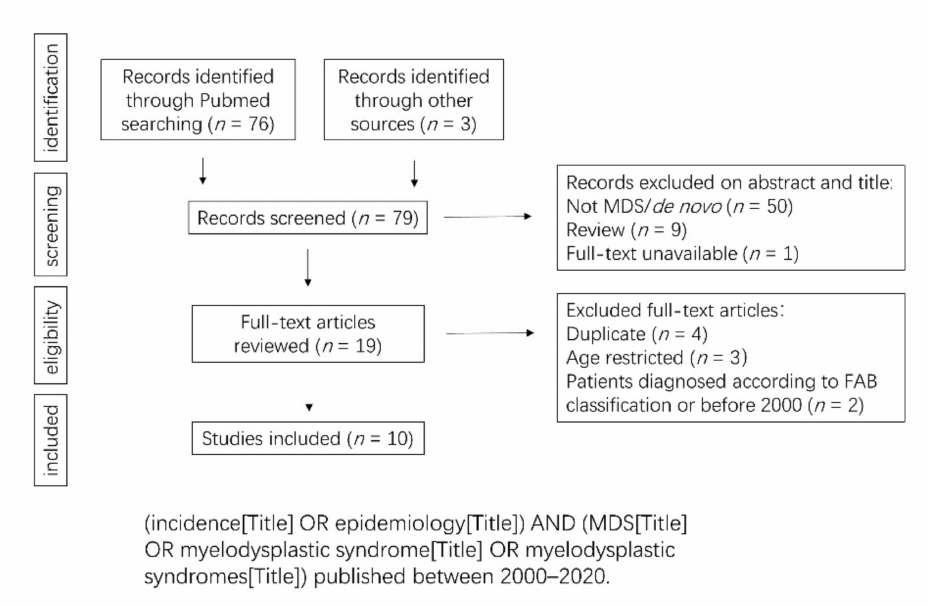
Figure 1. Flow chart for the process of identifying studies included in and excluded from the systematic review for the comparisons of MDS incidence and epidemiology